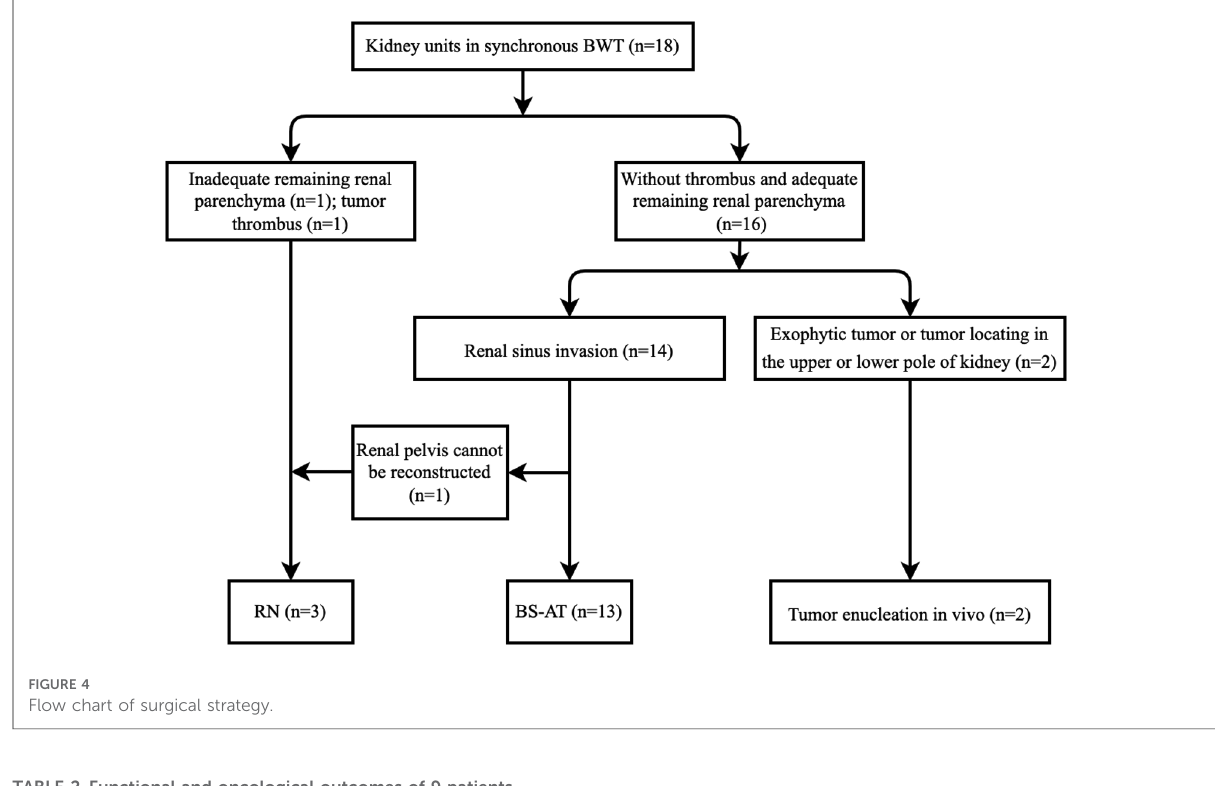
TABLE 2 Functional and oncological outcomes of 9